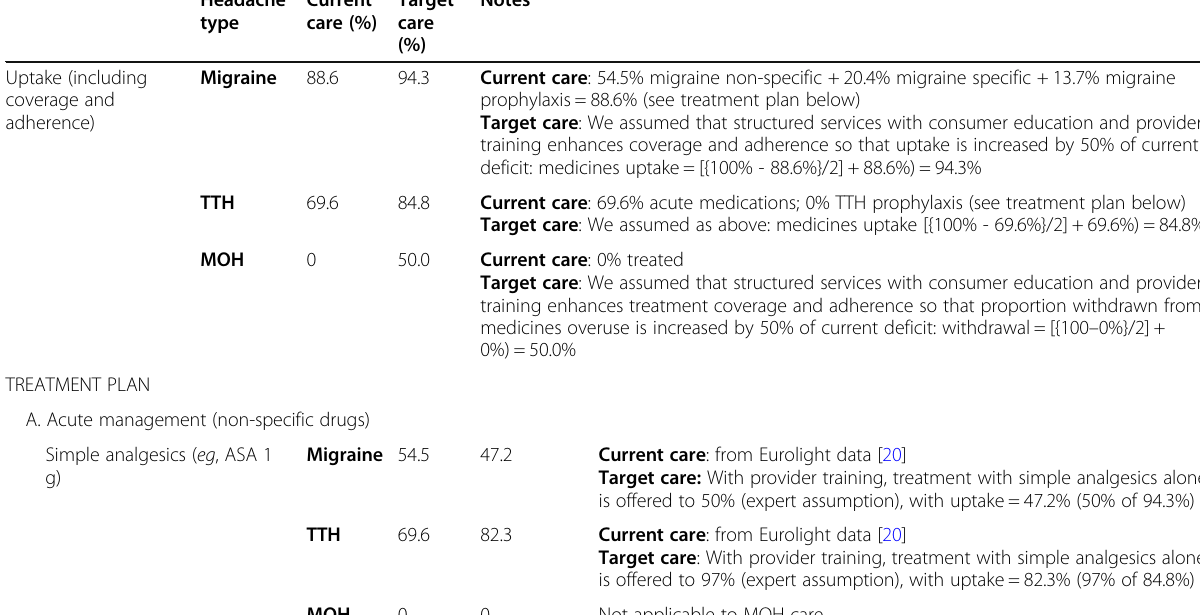
Table 3 Treatment uptake, use of resources and lost productivity according to treatment management plan